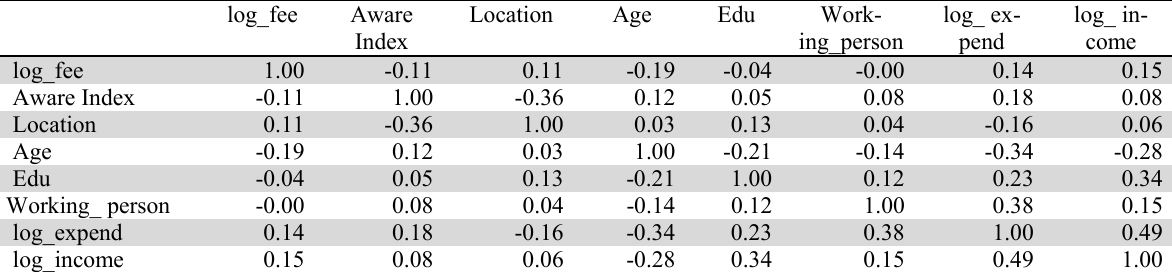
Correlation matrix of possible independent variables